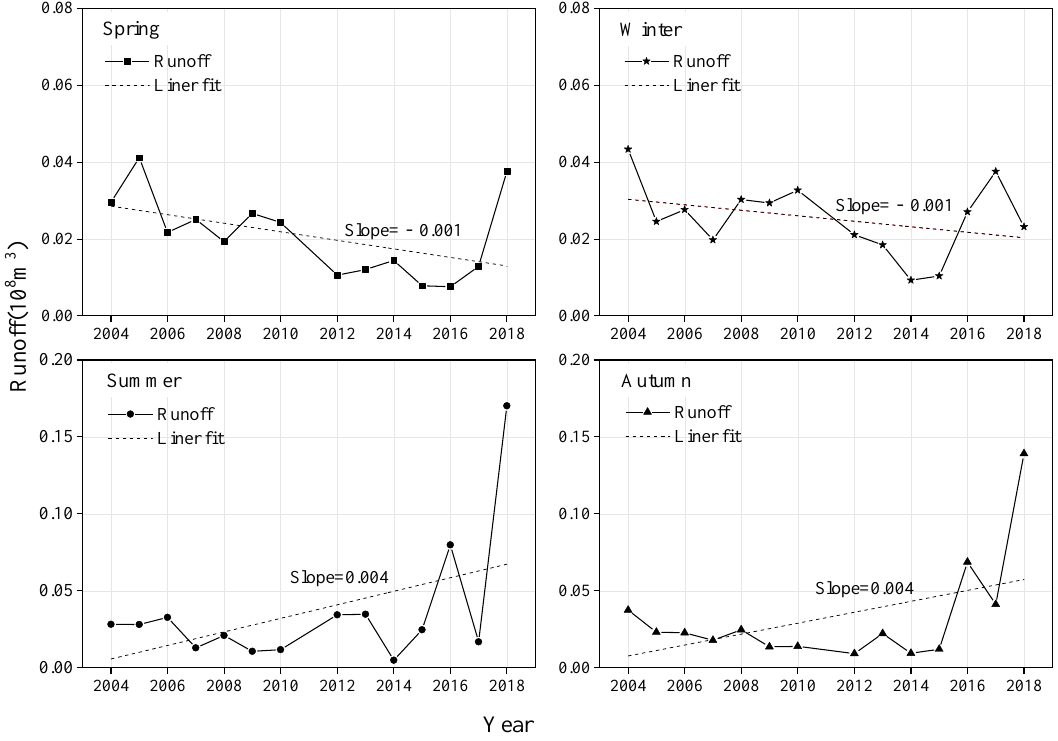
Figure 6. Seasonal runoff changing trend in the Dongdaqiao station from 2004 to 2018.